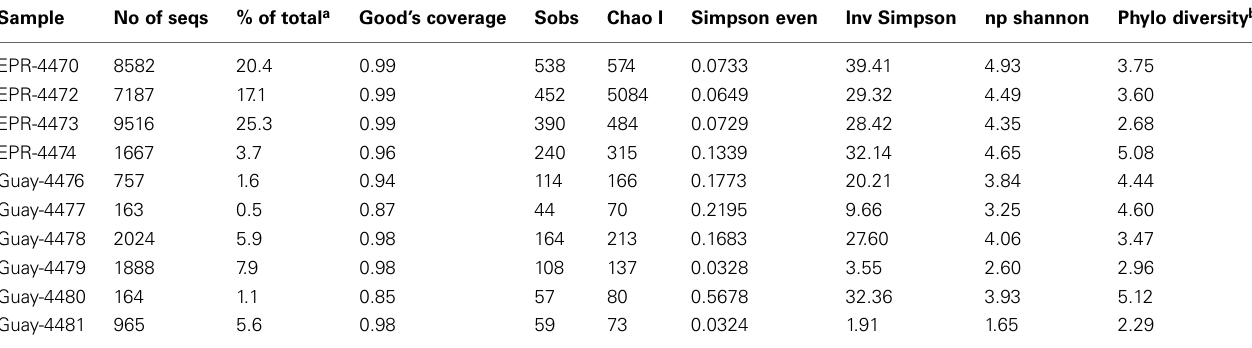
Table 4 | Diversity estimates from vent-specific 16S rDNA amplicons of diffuse flow vent samples collected at 9 ◦ N East Pacific Rise (EPR) and Guaymas Basin (Guay) hydrothermal vent sites.